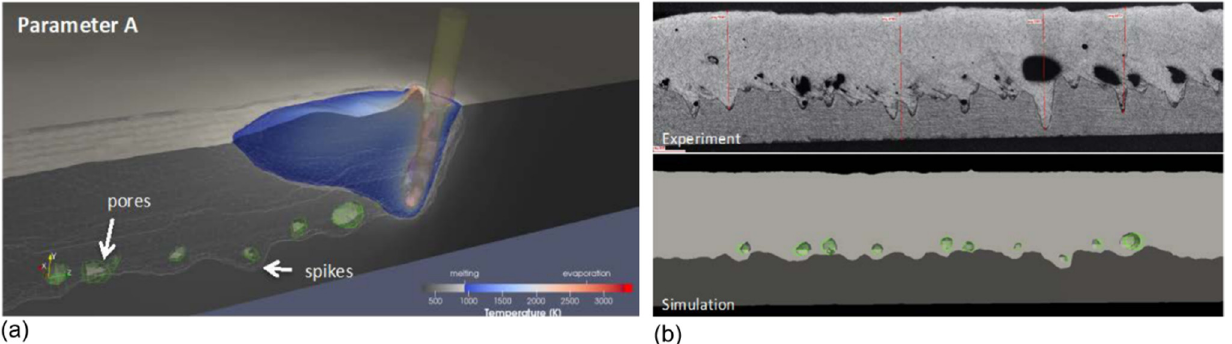
Figure 17. The spiking effect phenomenon generating ( a ) numerical modelling revealing porosities due to keyhole fluctuations and ( b ) appearance of longitudinal section. Pure Al (99.5%) 2.0 mm thick sheet. After Otto et al. [154].